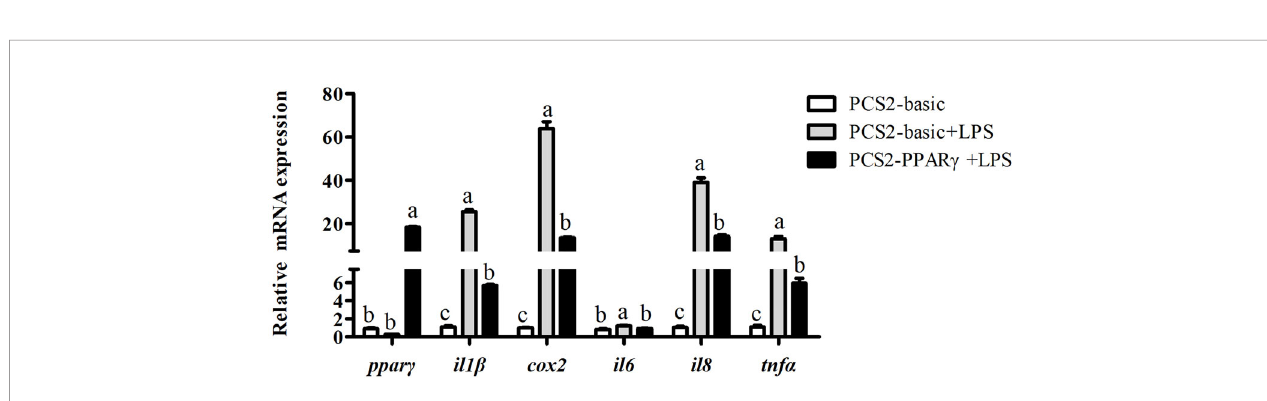
FIGURE 5 | Effects of PPAR g overexpression on LPS-induced expression of il1 b , cox2 , il6 , il8 , and tnf a in macrophages of large yellow croakers. Values are presented as mean ± S.E.M. (n = 4). For each gene, values in bars bearing the same letters were not signi fi cantly different among treatments ( P > 0.05).